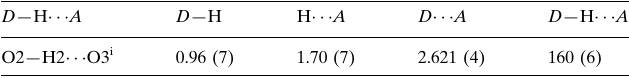
Hydrogen-bond geometry (A˚ , (cid:1)